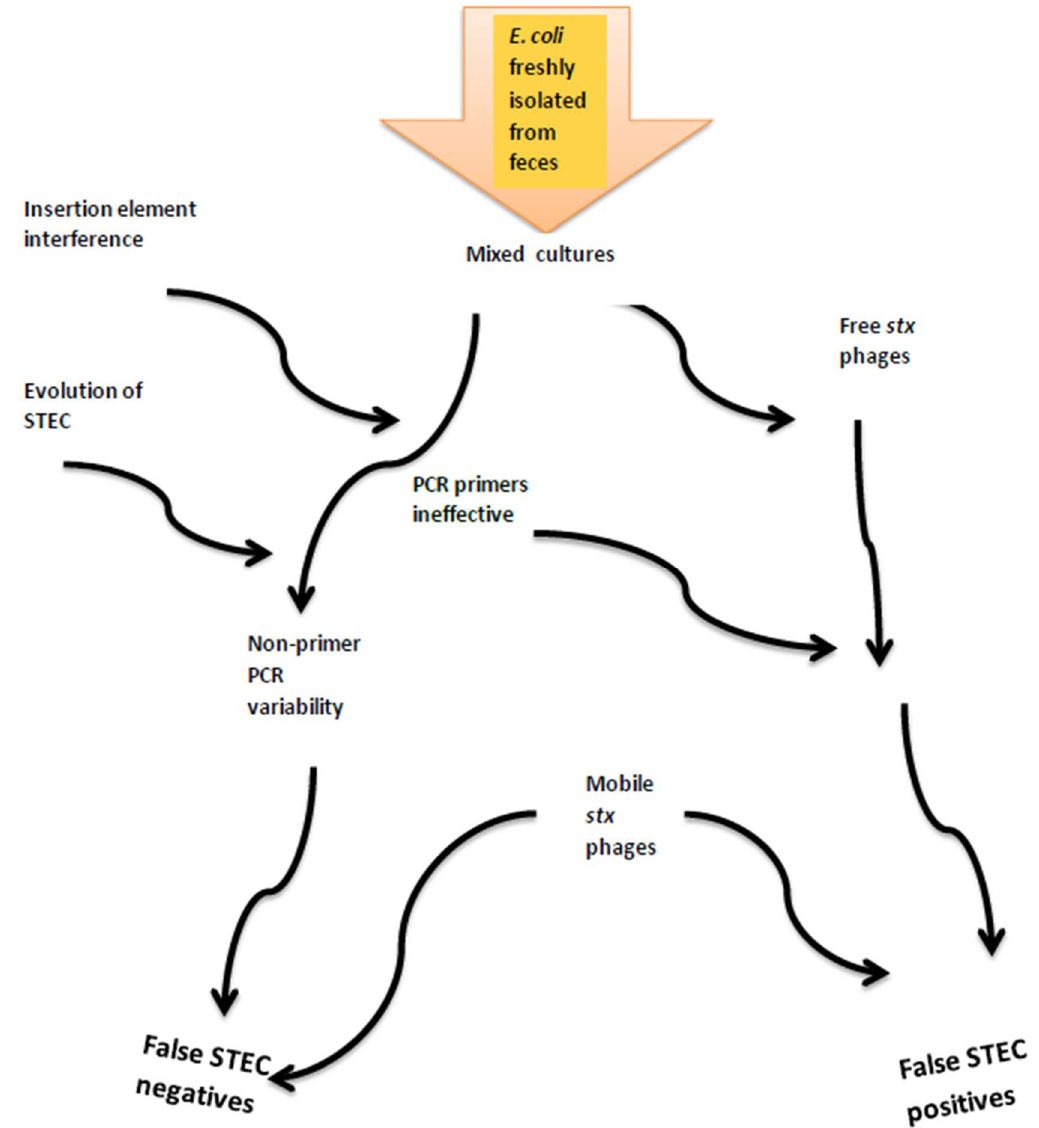
Figure 2. Factors contributing to cumulative errors in detection of Shiga toxin genes and classification of isolates as STEC.